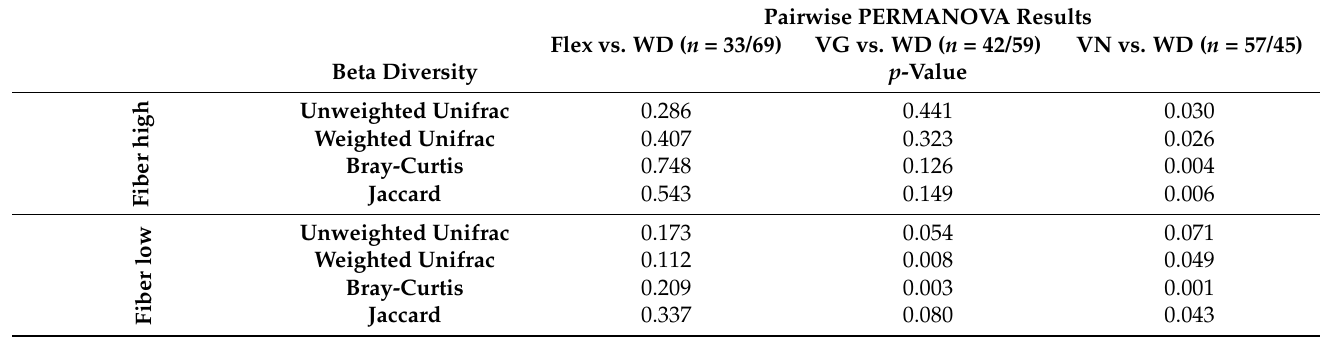
Table 4. Results of the pairwise PERMANOVA statistical analysis of beta diversity metrics comparison against WD/reference diet split between high fiber and low fiber content